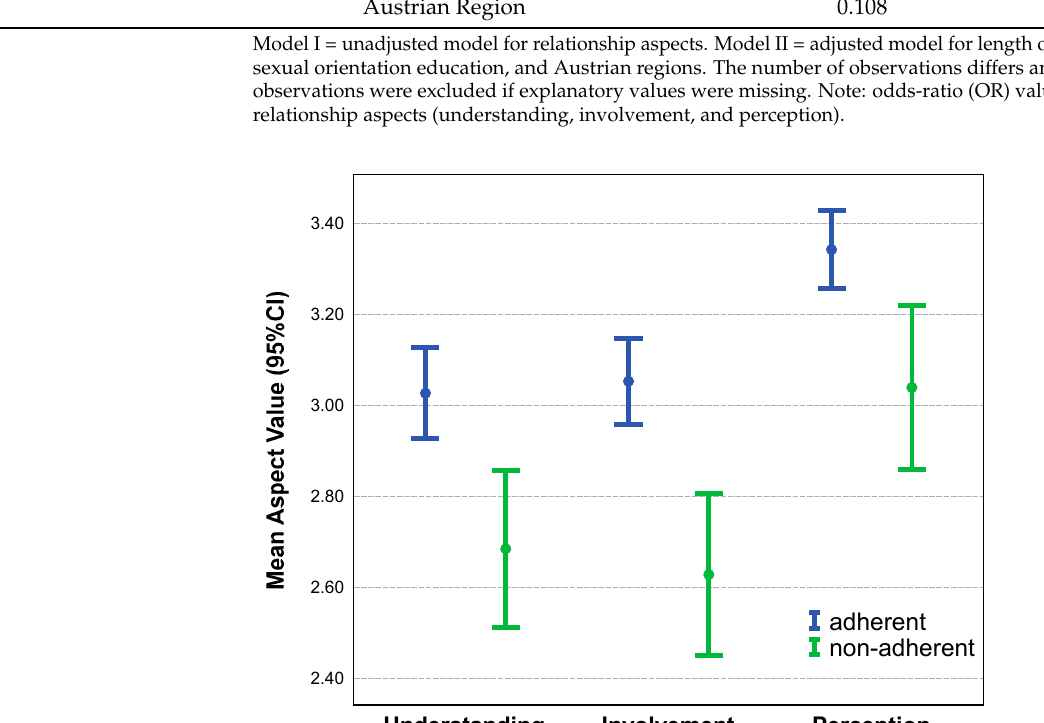
Table 2. Logistic regression for non-adherence on relationship aspects, including model adjust- ments for therapy duration and sociodemographic characteristics. Model